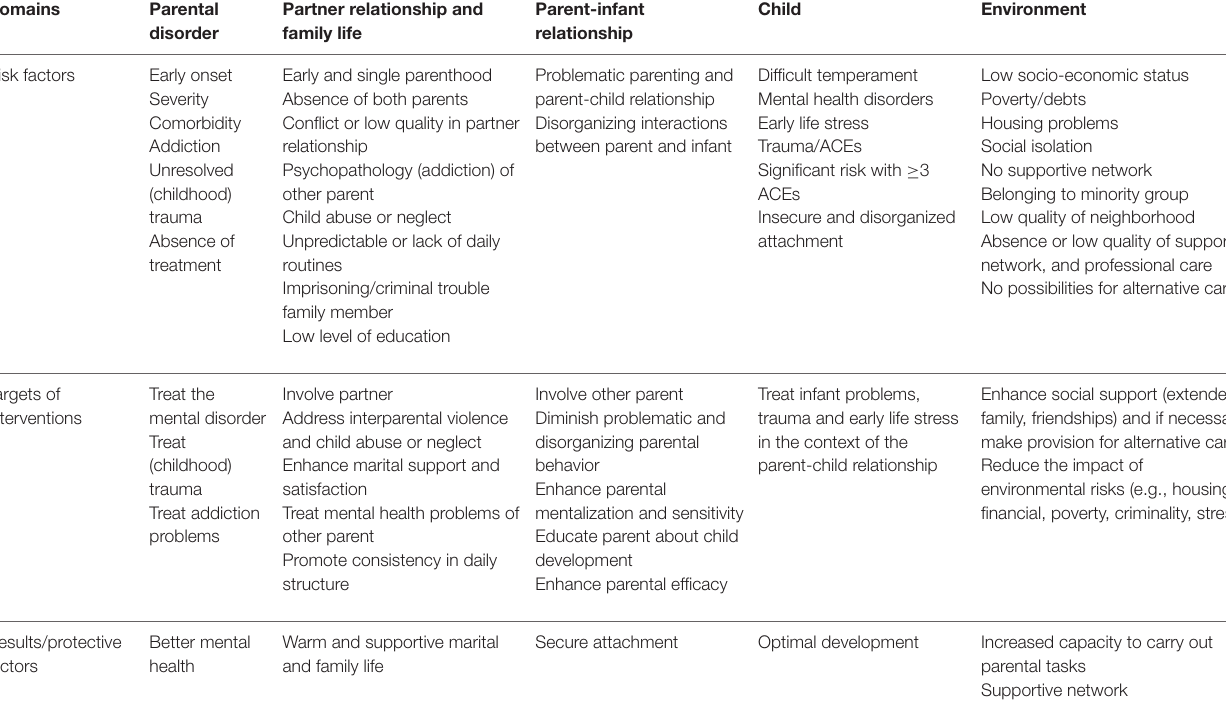
TABLE 3 | Risk factors and targets of intervention in different domains to prevent for intergenerational transmission of psychopathology and adverse outcome.